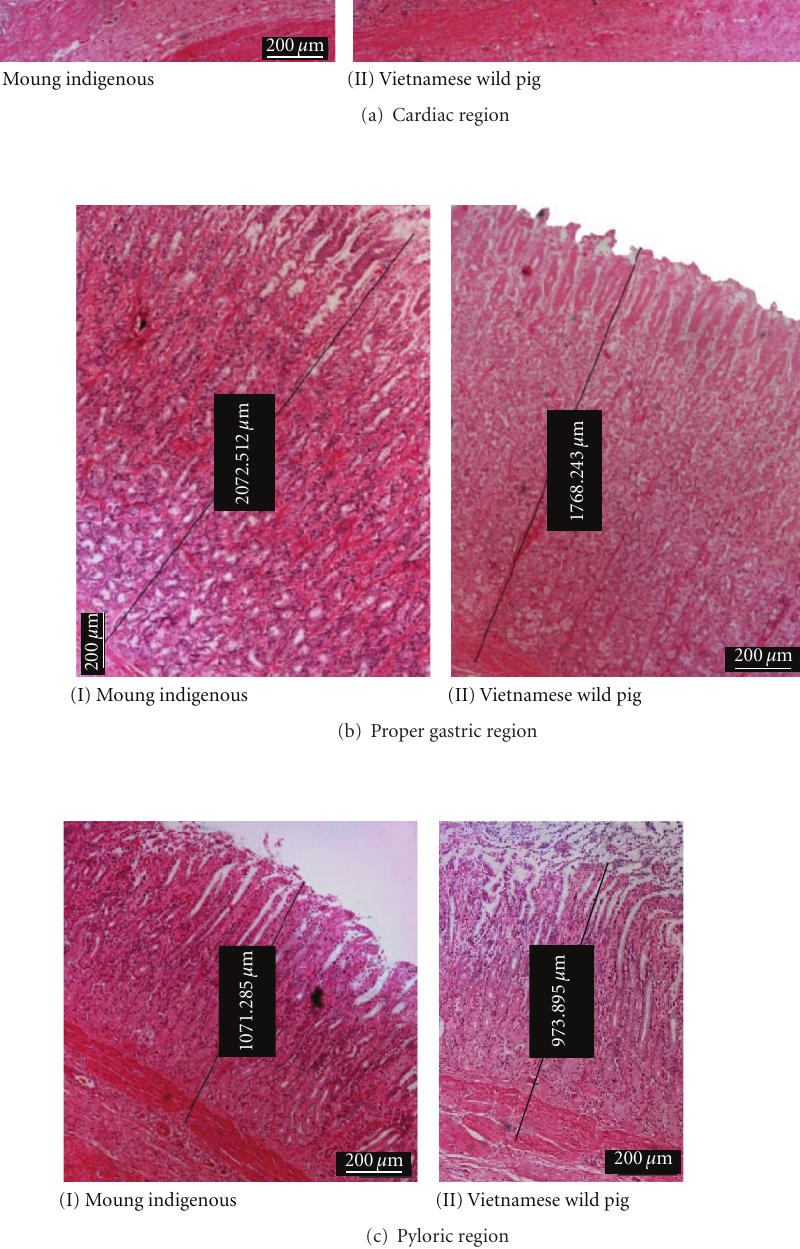
Figure 5: photomicrograph of H&E staining showing tissue di ff erences in thickness between both